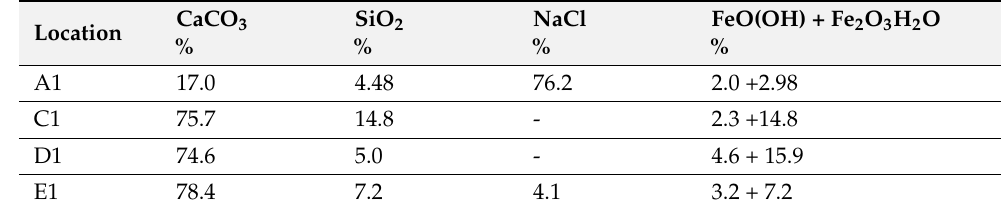
Table 3. Crystalized minerals in particulate material collected over the distance of the study system at locations A1, C1, D1 and